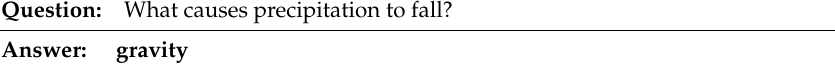
Figure 11. An example of textual MRC